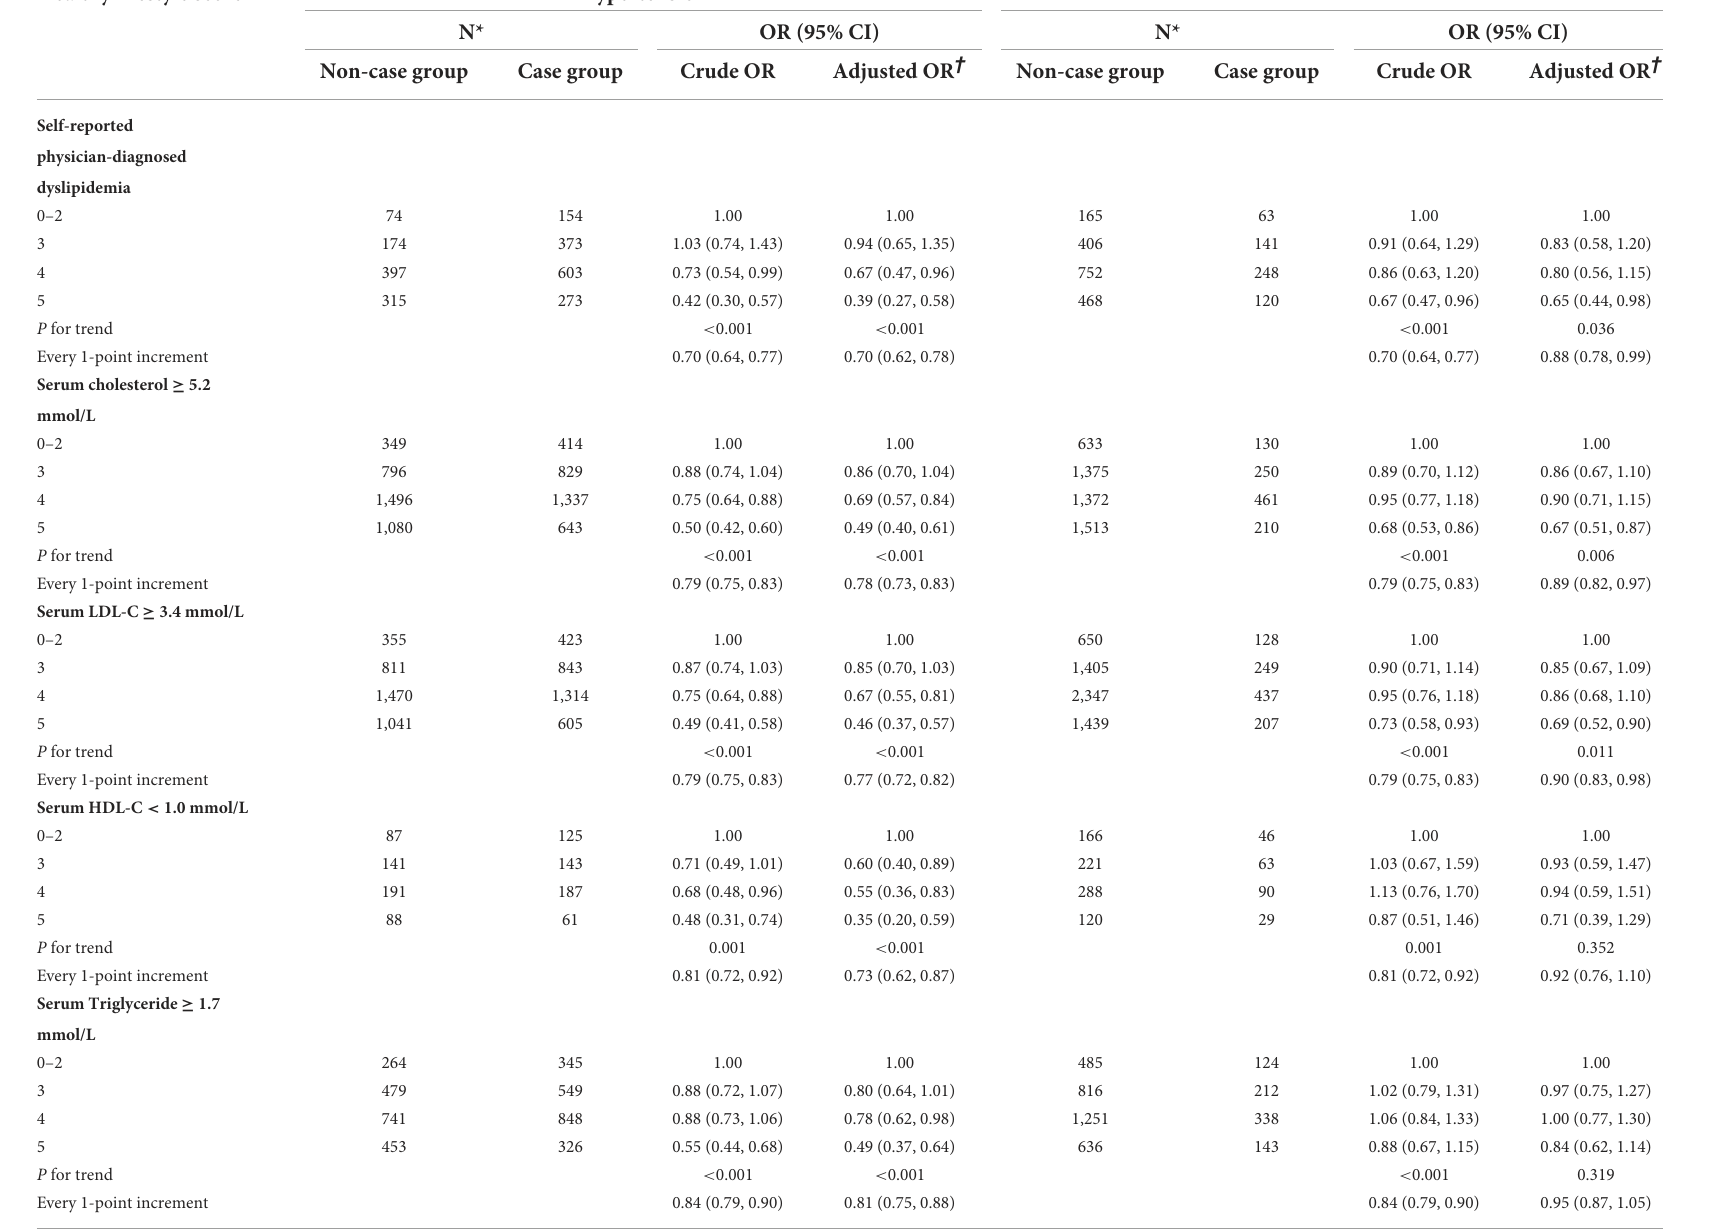
TABLE 5 Association between healthy lifestyle score and the risk of hypertension and T2DM according to different dyslipidemia definitions. Healthy lifestyle